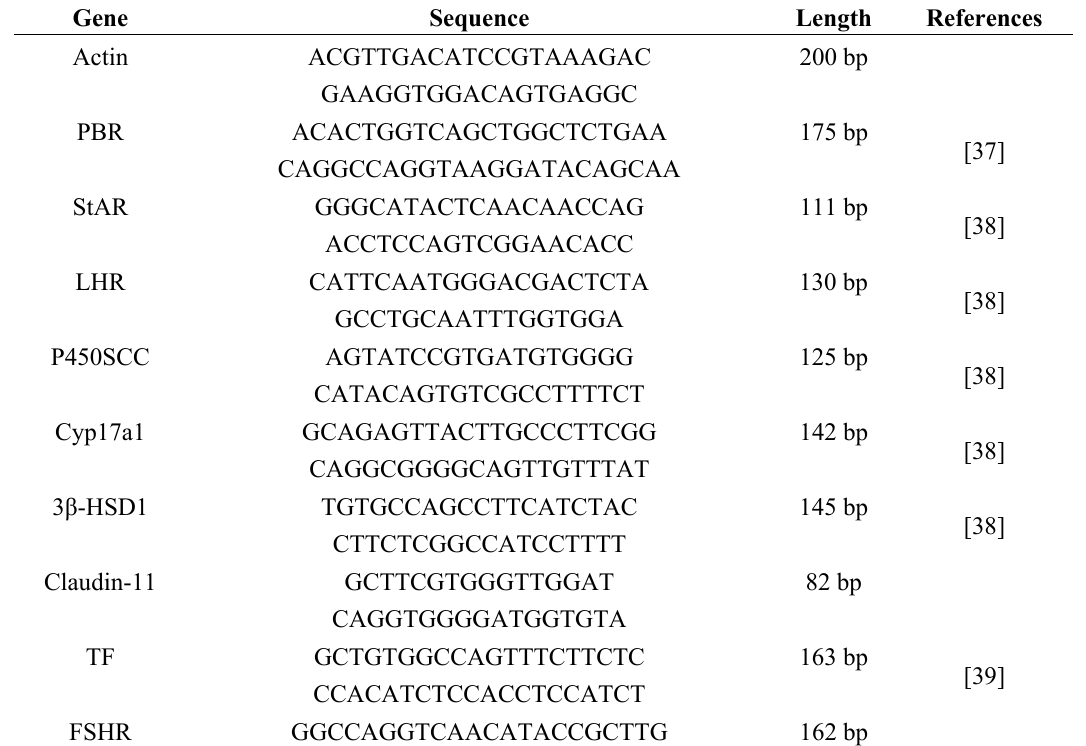
Table 2. Primer sequences used in RT-PCR